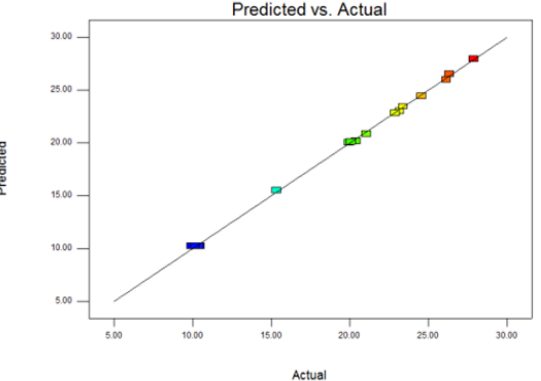
Figure 1. Experimental response values versus predicted response value of SS content.